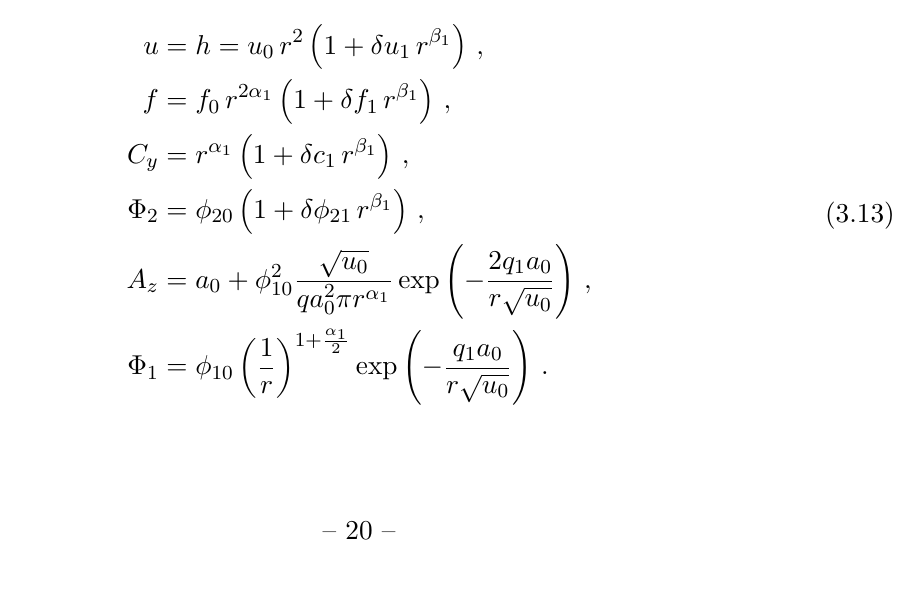
and { δu , δf = − δh , δc , δφ = 1 2 2 2 2 12 . Shooting to c/b = 1 we have the critical 2 2